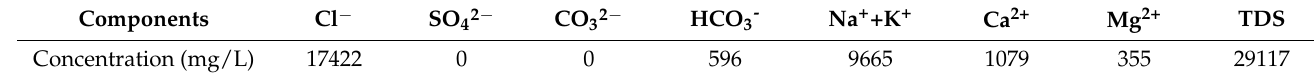
Table 1. Composition analysis of formation brine.